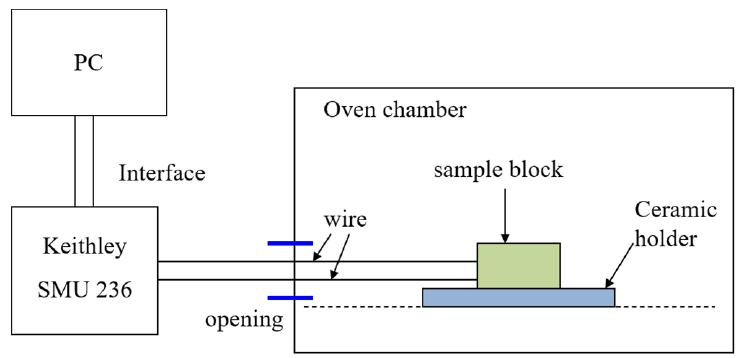
Figure 3. The schematic diagram for the reliability experimental setup.